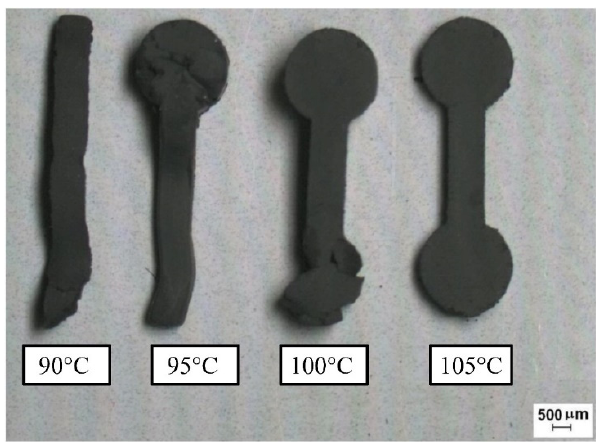
Figure 7. Green parts at different mold temperatures. Reproduced with permission from reference [33], copyright © 2014 Elsevier B.V.